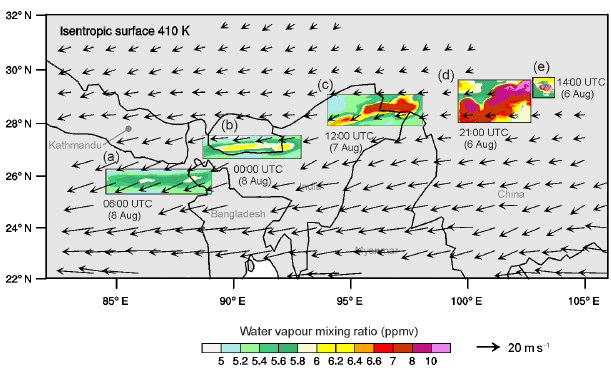
Figure 4. Target moist patch. Horizontal distribution of water vapour mixing ratio at 410K isentropic altitude at (a) 06:00UTC, and (b) 00:00UTC on 8 August, (c) 12:00UTC on 7 August, and (d) 21:00UTC and (e) 14:00UTC on 6 August 2017. The horizontal wind at the altitude of 19km (about 410K isentrope) at 06:00UTC on 8 August is displayed by